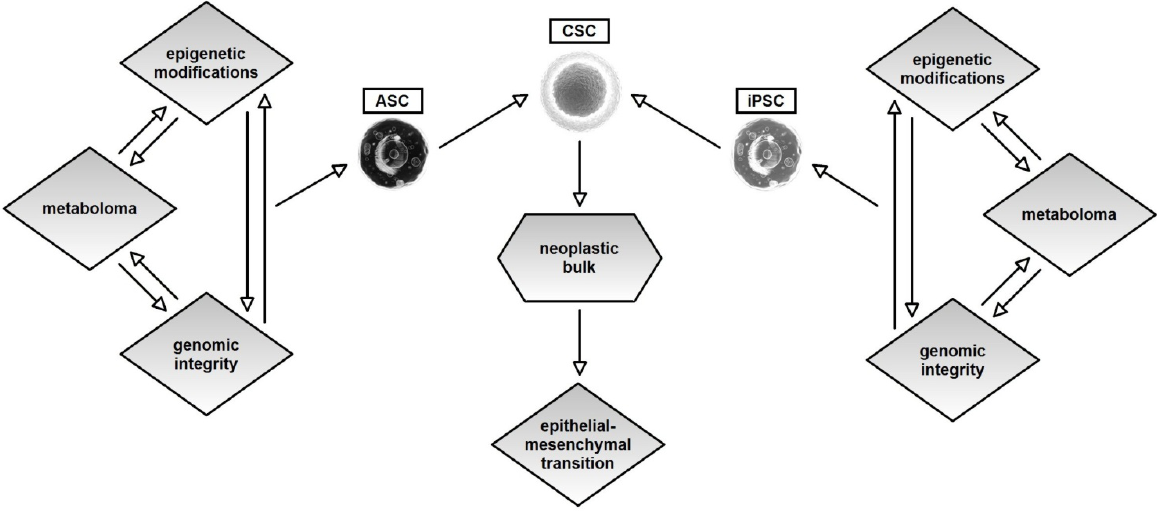
Figure 2. Figure 2 briefly summarizes our model in which, at the origin of a neoplasia, there are not only changes, genetic or epigenetic, but also triple synchronous changes in three systems, metabolic, genetic and epigenetic. We propose an integrative model that is based on cooperative and multiple changes in these three systems. Very probably, a change in one of these cellular systems is not sufficient cause but serves to prepare the cell. From all of these facts and from the growing evidence supporting the CSC theory, we can hypothesize that the transformation process, which foresees this triple progressive change in the three basis systems, occurs in stem cells that preside over self renewal (ASC) or in somatic cells that, by the lost of the correct metabolome and by the change in numerous genetic and epigenetic systems, proceed to a process of somatic rescheduling (iPSC). Certainly, the energetic homeostasis, mitochondrial function and the metabolome as a whole play roles of equal importance in genetic or epigenetic phenomena. From this perspective, more care and attention should be given to other well-know